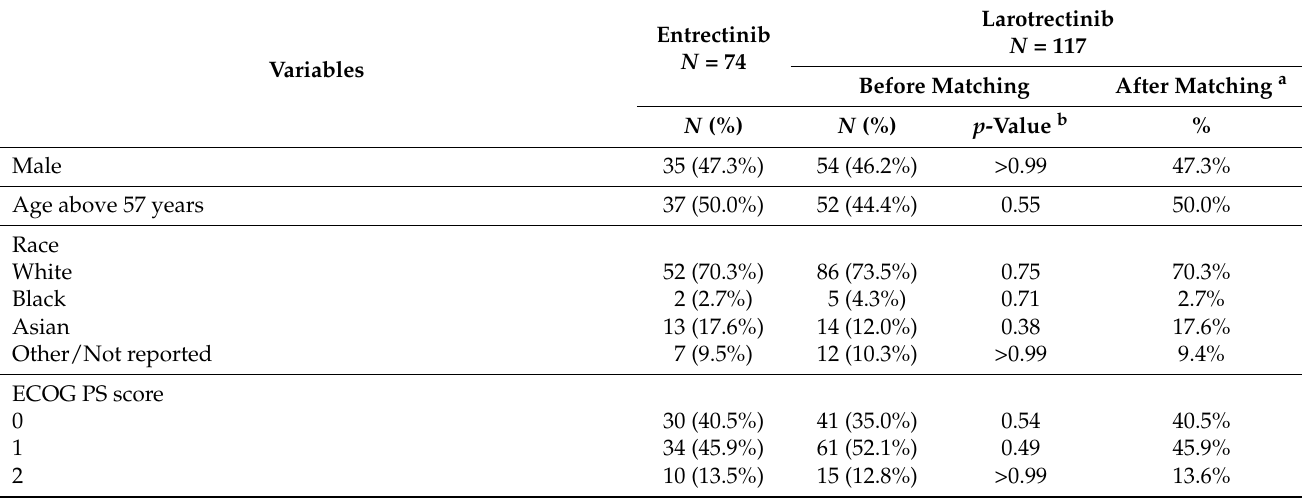
Table 1. Baseline characteristics before and after matching of larotrectinib efficacy population and